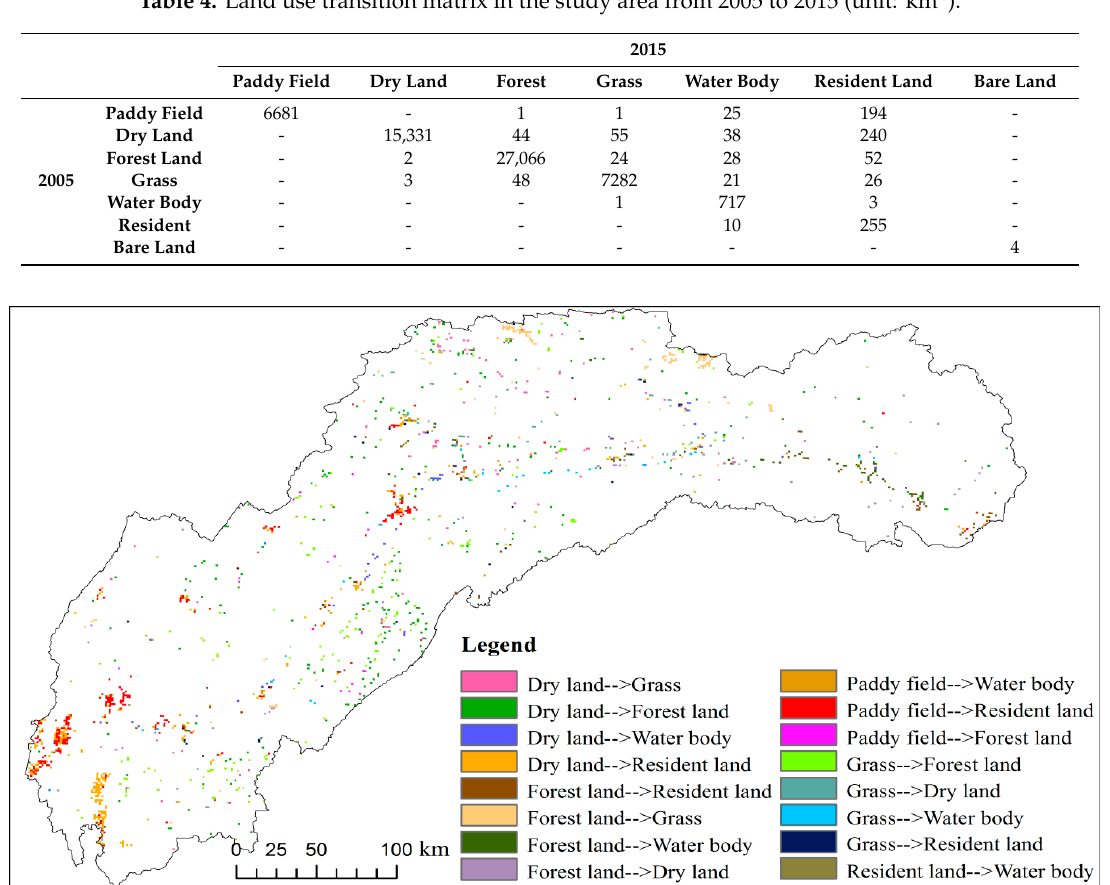
Figure 3. Spatial transfer map of main land use types in the study area from 1995 to 2015.